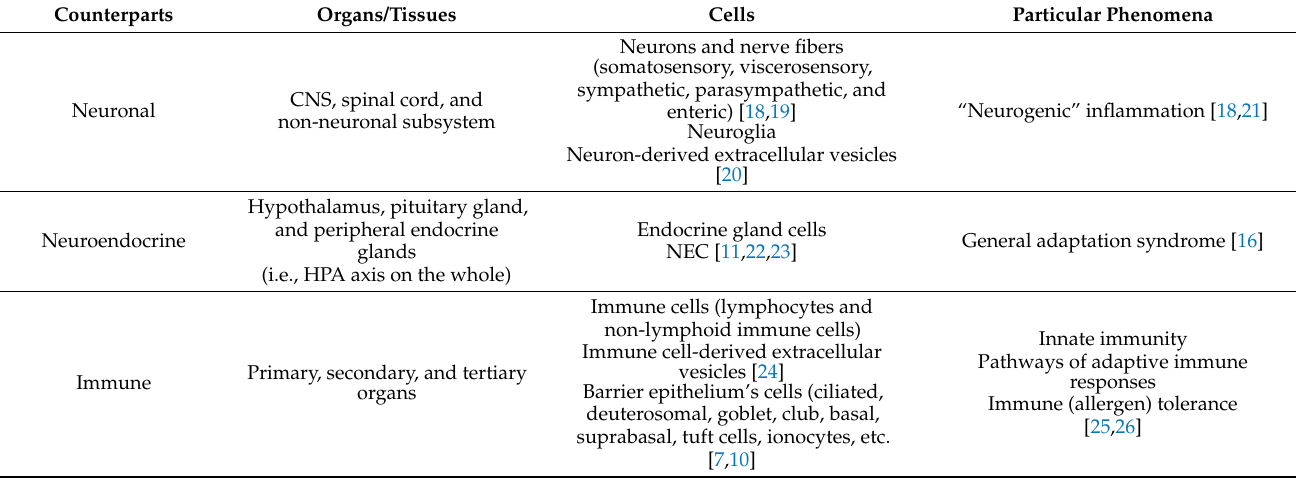
Table 1. The neuroimmune